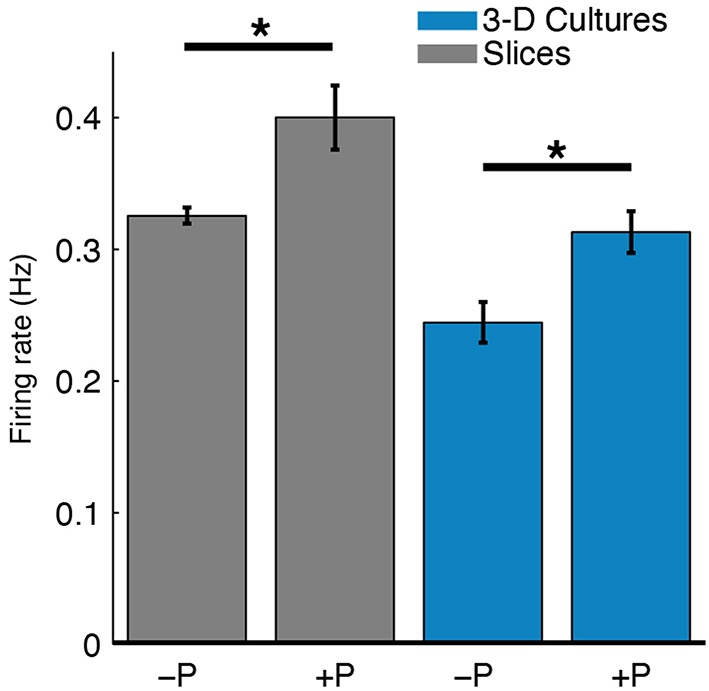
Perfusion increased spontaneous firing rates of both slices and 3-D cell cultures. The mean spike detection rate (Hz) per electrode was higher in perfused (+P) cultures compared to unperfused (−P) control cultures (*P < 0.05, two-sample t-test). A single average firing rate value was taken at each DIV for each culture type. The effect of perfusion was statistically significant as analyzed with 2-way ANOVA (P < 0.05; nine slices, six 3-D cultures, see Results for more details). This relatively greater firing rate for perfused cultures may reflect either more live cells near electrodes or greater cellular activity.